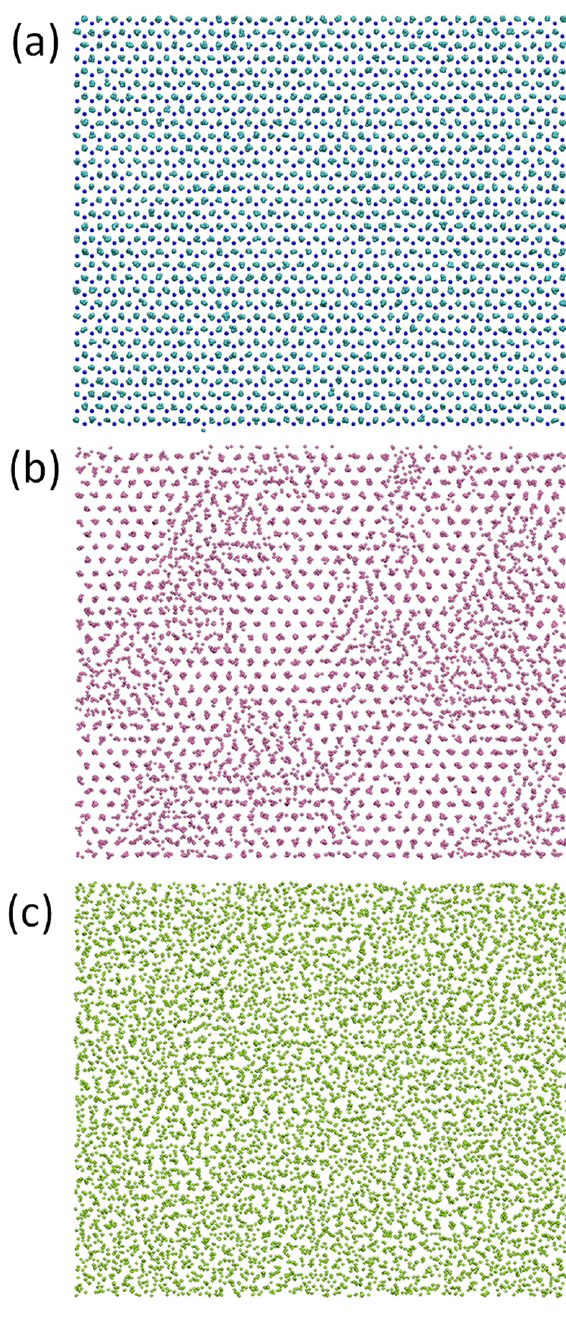
Figure 7. Prenucleation in systems with small positive misfits [24]. The time-averaged atomic positions for ( a ) L1 on top of the surface layer of the substrate (L0), ( b ) L2, and ( c ) L3 in the liquid adjacent to the liquid/substrate interface with 4% misfit equilibrated at T = 1000 K. L1 has an ordered structure and is epitaxial to the L0, L2 has a mixed structure, and L3 is largely disordered.